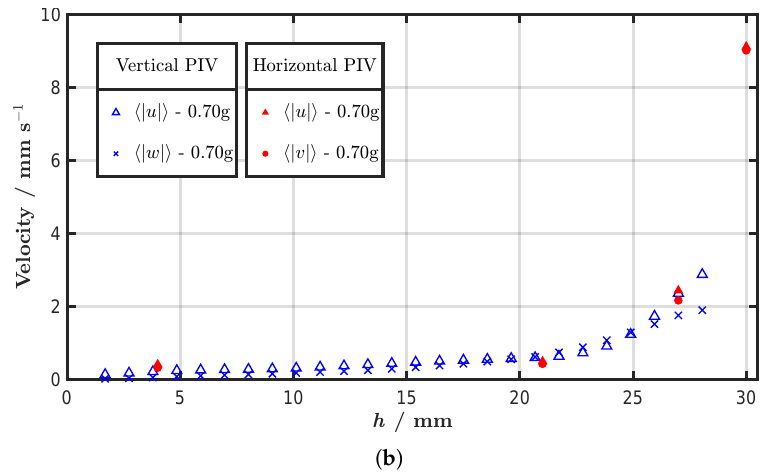
Figure 4. Profiles of absolute values of velocity components (cid:104)| u |(cid:105) , (cid:104)| v |(cid:105) , and (cid:104)| w |(cid:105) against the distance from the container bottom h for vertical and horizontal PIV measurements (empty and filled markers, respectively). Forcing accelerations a f = 0.47g ( a ) and a f = 0.70g ( b ). Values are averaged across